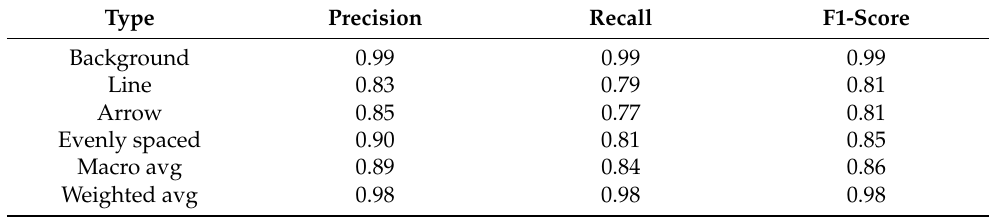
Table 5. The multi-label classification reports macro-average and the weighted average for Precision , Recall , and F 1